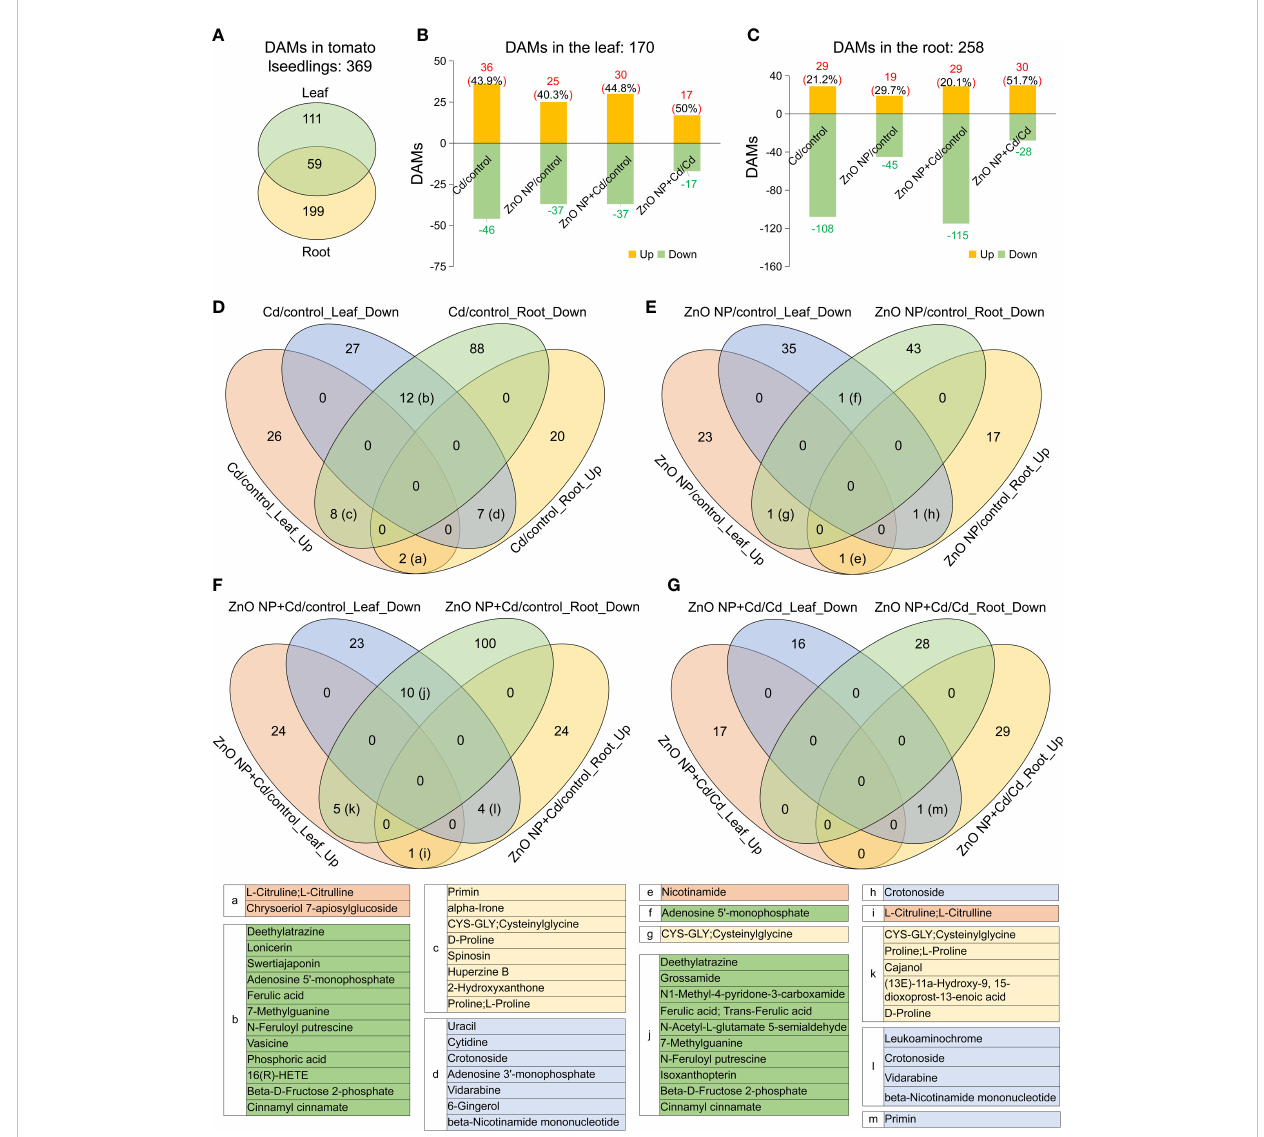
FIGURE 5 Differentially accumulated metabolites (DAMs) in tomato seedlings. (A) Venn diagram analysis showed the overlapping DAMs between leaves and roots. B and C, The number of upregulated and downregulated DAMs in the leaves (B) and roots (C) of the Cd/control, ZnO NP/control, ZnO NP +Cd/control and ZnO NP+Cd/Cd comparisons. D-G, Venn diagram analysis of DAMs in the leaves and roots of (D) Cd/control, (E) ZnO NP/control, (F) ZnO NP+Cd/control and (G) ZnO NP+Cd/Cd comparisons. Up, upregulated metabolites; Down, downregulated metabolites. The tables below list the DAMs in the intersections (a-m) in the Venn diagrams from D to